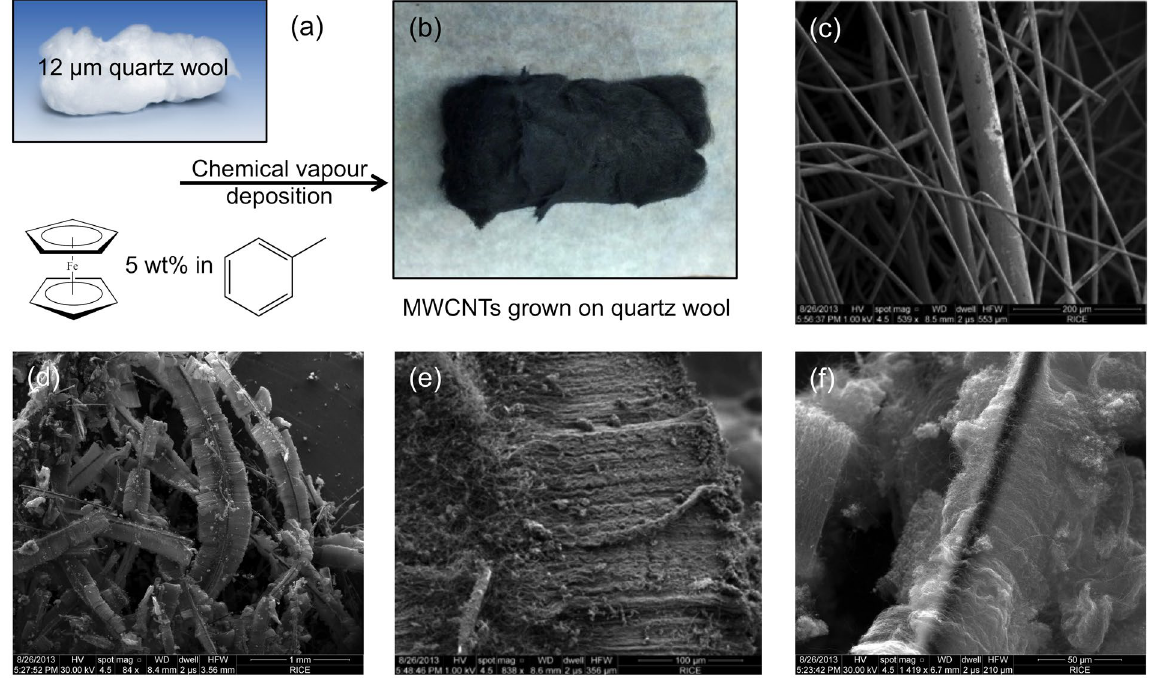
Figure 1. Images of the quartz wool supported-CNTs. ( a ) Schematic of the reaction for the growth of CNTs on to the quartz wool support showing ( b ) an optical image of the as grown quartz wool supported CNTs. SEM micrographs of ( c ) the quartz wool substrate, ( d and e ) the as grown quartz wool supported CNTs and ( f ) the supported epoxidized CNTs